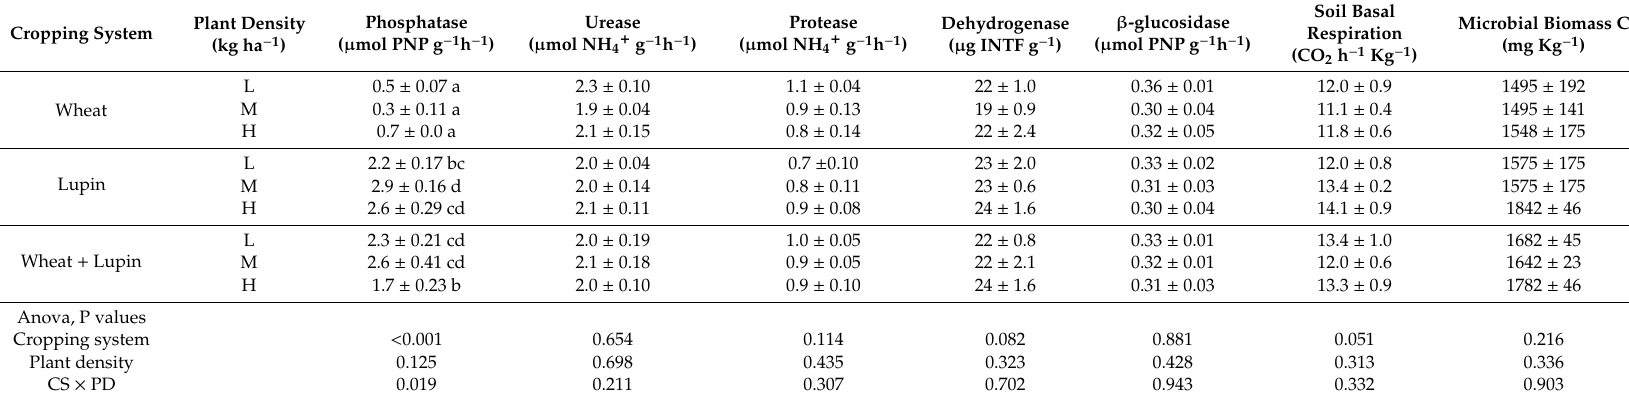
Table 2. Soil microbiological properties and enzyme activities in response to monocropping and intercropping at di ff erent plant densities under field conditions. Cropping System